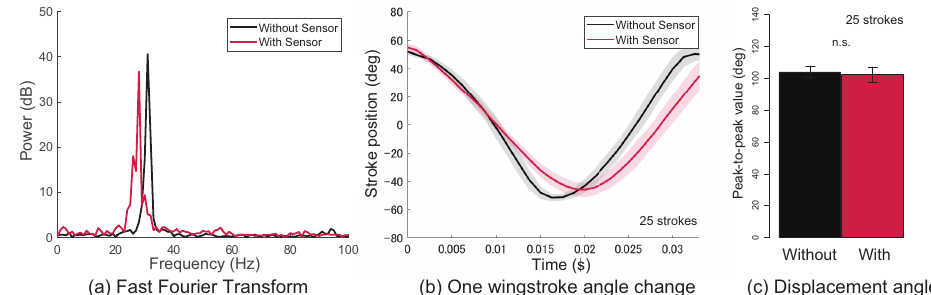
Figure 5. Evaluation of the effect of flapping when the sensor is attached to a silk moth. ( a ) Flapping frequency, ( b ) the flapping displacement angle change of one wingstroke, and ( c ) the peak-to-peak value of the flapping angle.